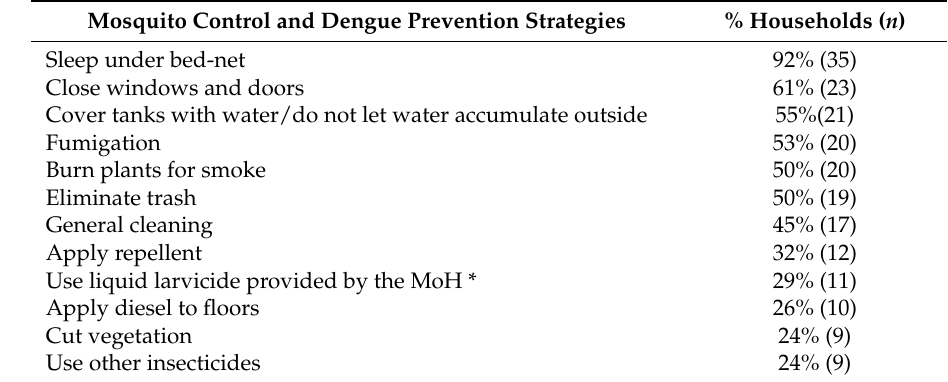
Table 2. Mosquito control and dengue prevention strategies reported by survey respondents ( n =